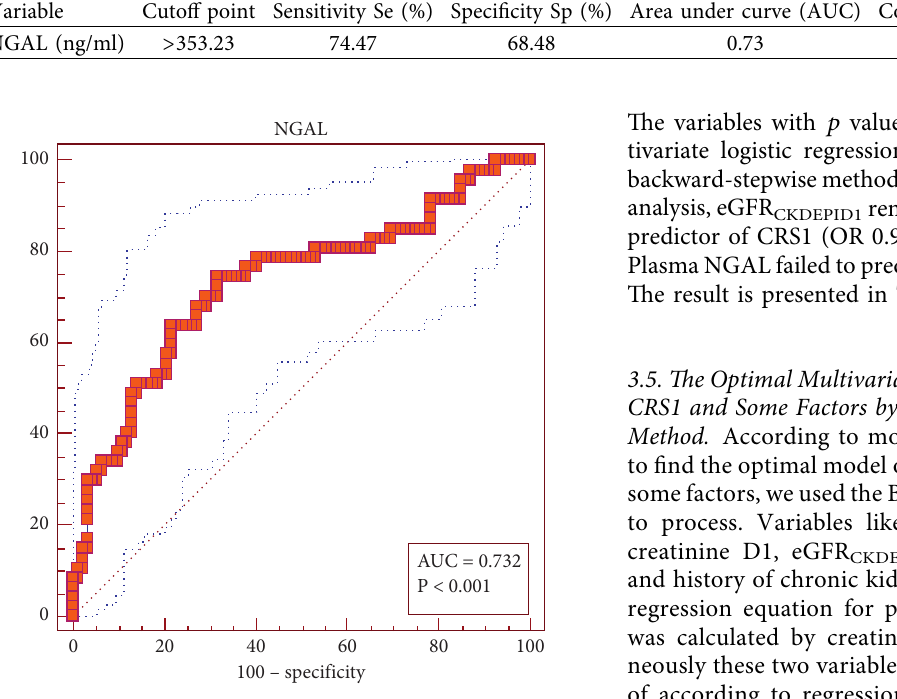
Figure 1: Cutoff point, sensitivity, and specificity of plasma NGAL for diagnosing